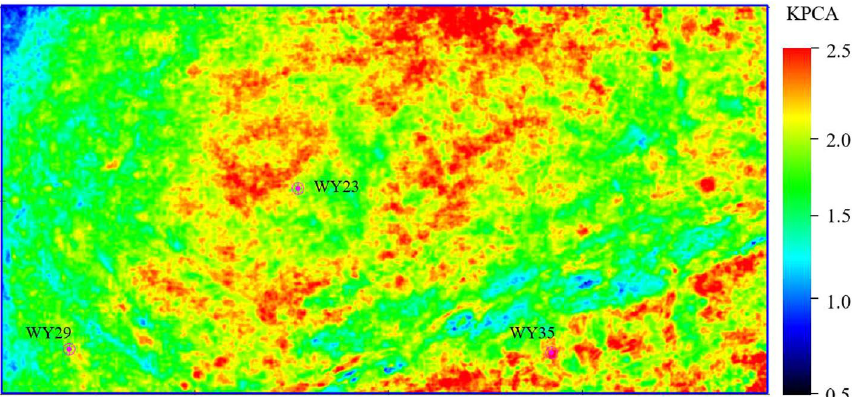
Figure 17. The first component of the KPCA result of the TOC, PHI and